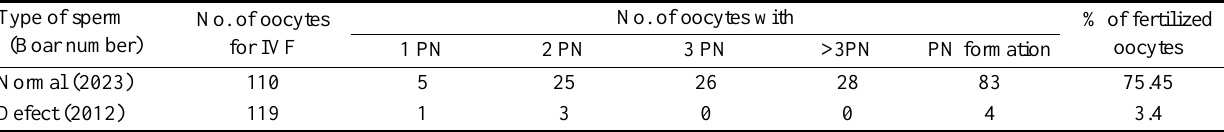
Table 2. Analysis of sperm fertilization ability using IVF Type of sperm